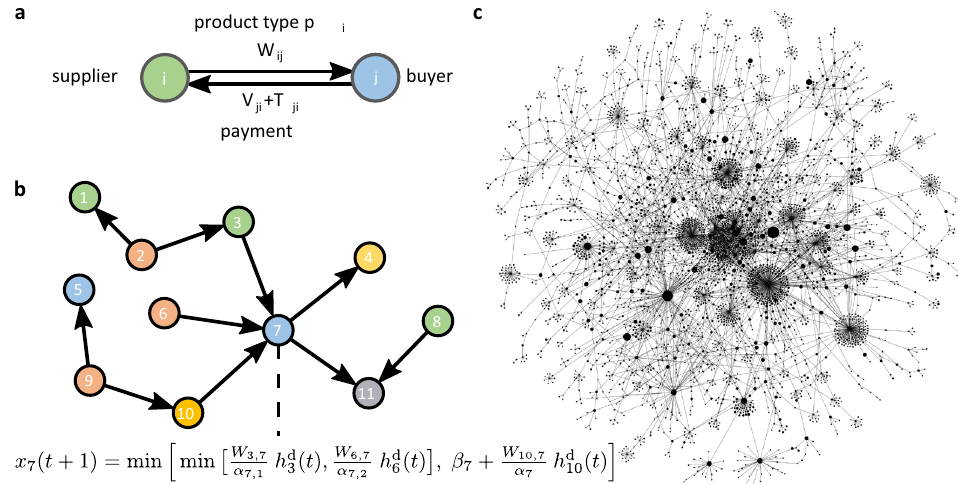
Figure 1. Reconstructing the production network. ( a ) Schematic supplier-buyer transaction between two companies, i and j . Supplier i produces products of type, p i , and delivers the quantity W ij to buyer j . The buyer makes a gross payment consisting of the net price, V ji , and the value added tax, T ji . ( b ) Production network consisting of 11 firms. Color represents firms’ industry affiliation, p i . Delivered goods and services are recorded in the weighted adjacency matrix, W ij ; element W ij records the volume delivered from i to j , and h d i ( t ) represents the relative production level of firm i at time t . The generalized Leontief production function from Eq. (1) is shown for firm 7 as an example. It uses three types of input, p 3 , p 6 and p 10 from firms 3, 6, and 10 and can produce the amount x 7 ( t + 1 ) of product p 7 . Note, firms 3 and 6 supply essential products to firm 7, whereas firm 10 sells non-essential goods to firm 7. Firm 7 sells its output to firms 4 and 11. For simplicity we omit edge weights. ( c ) Section of the Hungarian production network with 4,070 nodes and 4,845 links. Node size corresponds to the total strength (proxy for company size). Many supply “chains” are connected and form a tightly knit supply